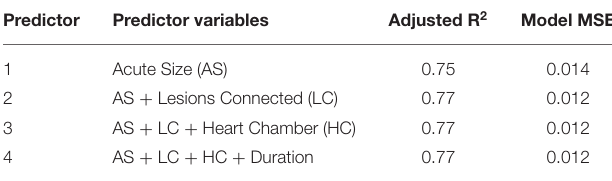
TABLE 2 | Adjusted R 2 and model MSE for each predictor’s